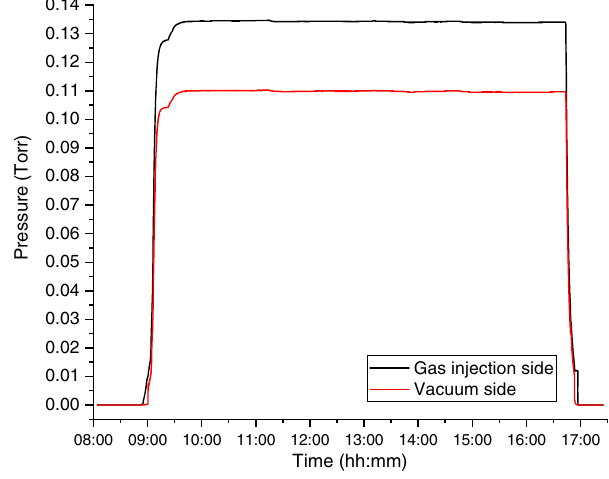
FIG. 7. Pressure measured at the two ends of the vCM during initial neon-oxygen mixture injection and during the flow maintained for the entire duration of plasma processing. The pressure drop across the string is approximately 24 mTorr. The pressure values are scaled to account for the gauge sensitivity to neon. These data were acquired during plasma processing of